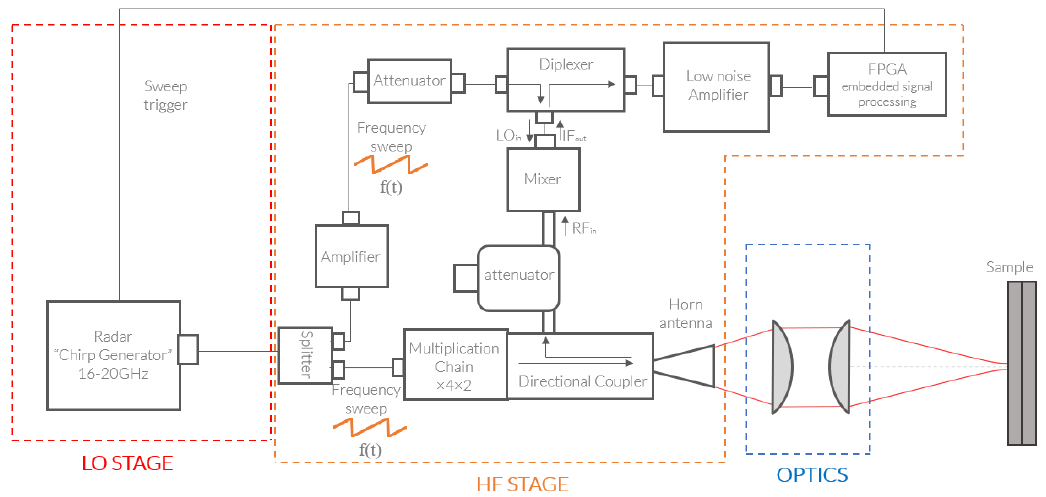
Figure 1. Full FMCW radar architecture diagram, featuring the low-frequency stage, the high- frequency, homodyne detection and emission stage, and the optics.